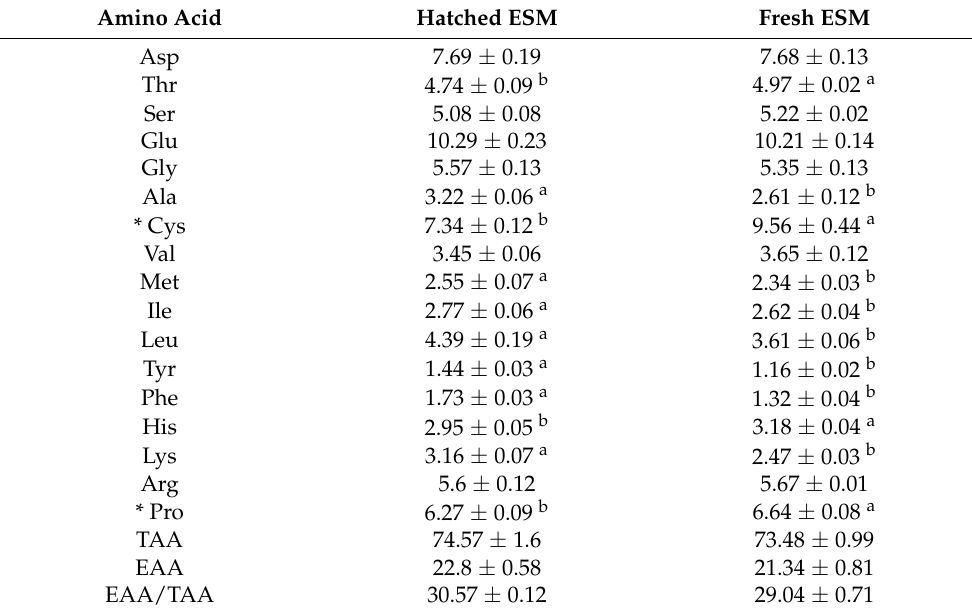
Table 2. The composition of amino acids (g/100 g protein) in hatched and fresh ESM. Amino